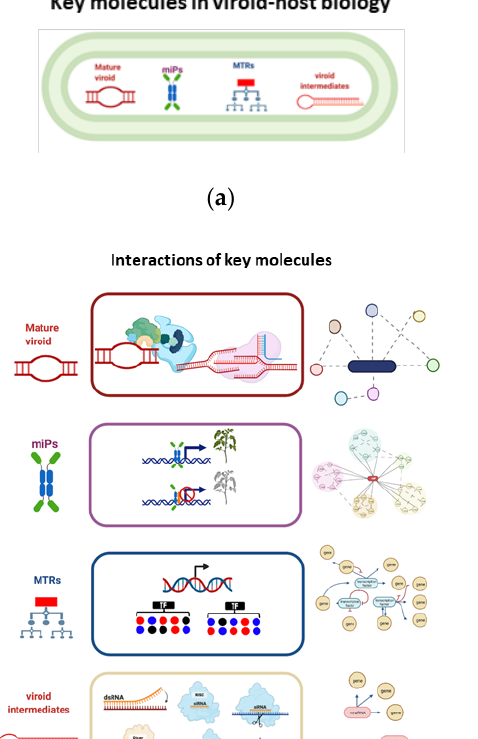
RNAs (vd-siRNAs) that guide mRNA degradation. Dotted arrows indicate the putative links among the different RNA-mediated regulation processes. Illustration created with BioRender.com.